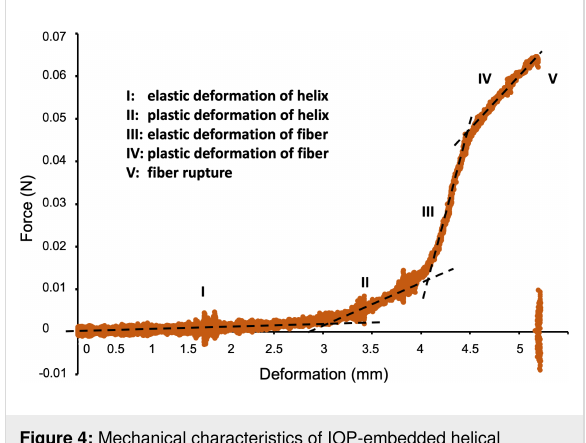
Figure 4: Mechanical characteristics of IOP-embedded helical chitosan fibers showed different deformation regimes until the composite fiber